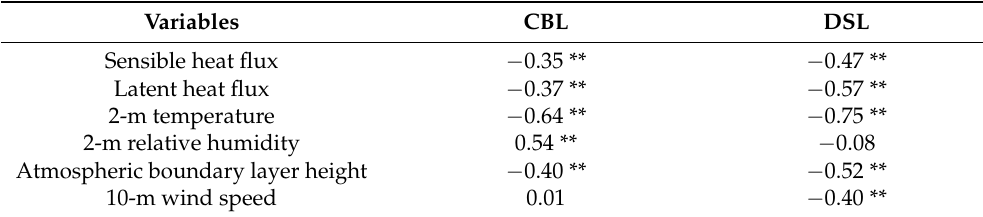
Table 2. Correlation coefficients of PM 2.5 concentration difference with influencing factor difference between lake experiment and no-lake experiment. Variables CBL DSL Sensible heat flux − 0.35